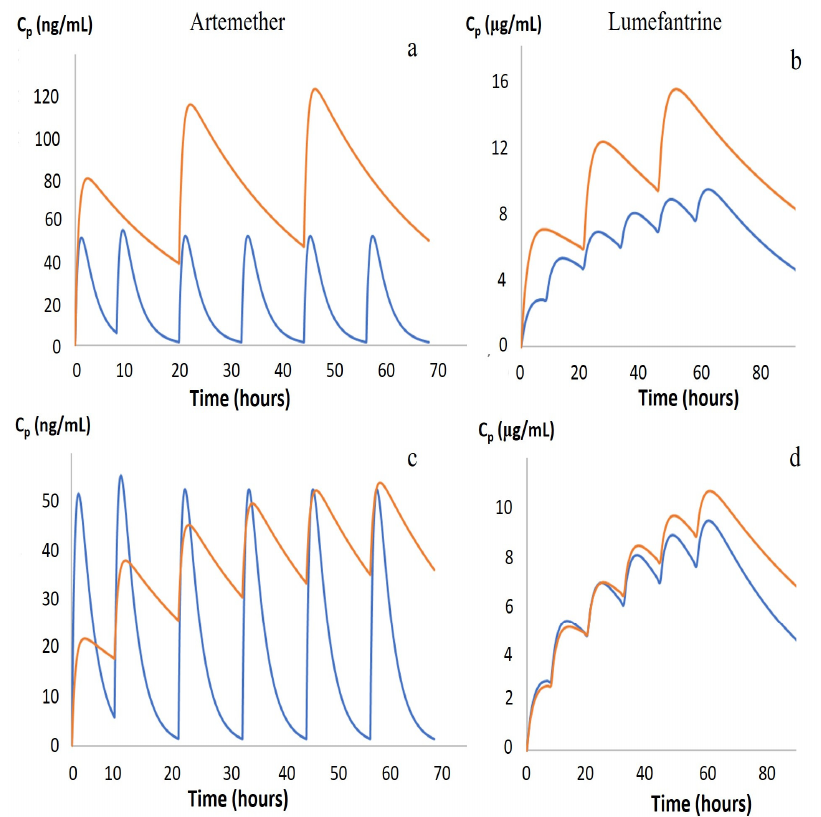
Figure 3. Plasma concentration time profiles of artemether and lumefantrine in adults and children. In ( a , b ), the dose-regimen has been changed for children in such a way that children take their medicine once a day, not at times 0, 8 h, then every 12 h for 3 days, where the pharmacokinetics for artemether ( a ) and lumefantrine ( b ) are shown. In ( c , d ), the dose of artemether has been adjusted for children to 0.34 mg/kg instead of 5–24 mg/kg ( c ); the dose for lumefantrine has been adjusted to 6 mg/kg instead of 29–244 mg/kg ( d ).